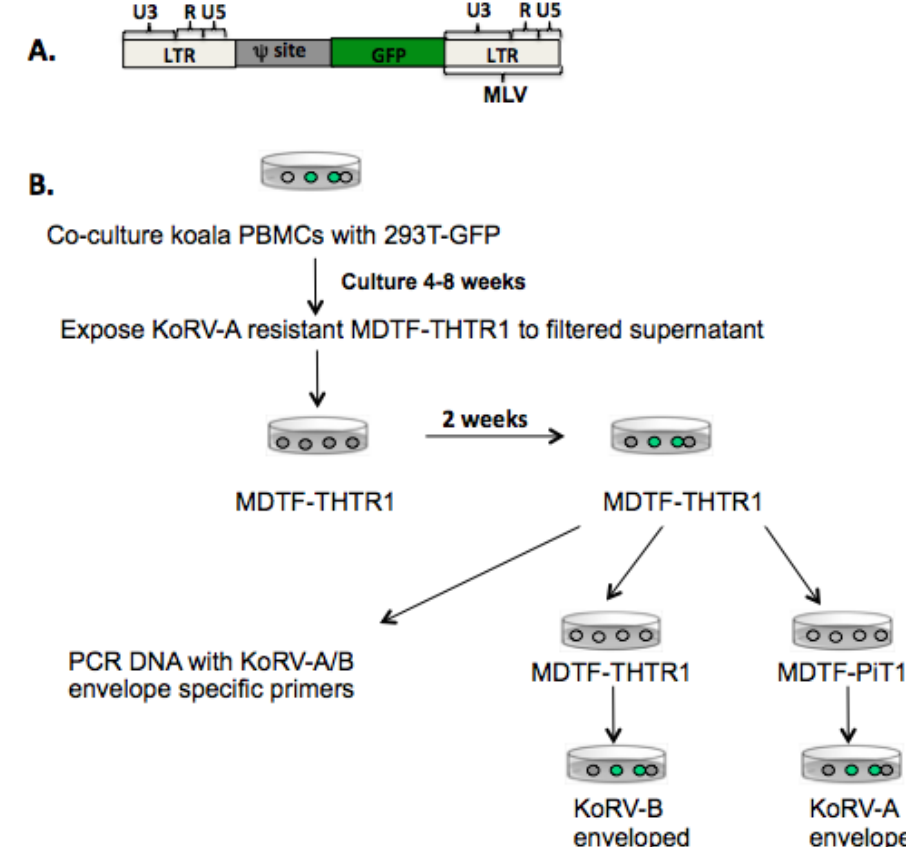
Figure 2. ( A ) Genomic organization of the defective GFP expressing retroviral vector. The long terminal repeats (LTRs) including U3, R, and U5 regions are derived from Moloney murine leukemia virus (Mo-MLV). The defective GFP genome is integrated into the genome of 293T-GFP cells and can be rescued after co-culture with koala PBMCs harboring infectious KoRVs; ( B ) Experimental design used to determine whether KoRV-B envelopes can pseudotype the KoRV-A genome. Green-filled circles indicate GFP expressing cells. Infectious KoRV-B enveloped viruses obtained by co-culturing 293T-GFP with